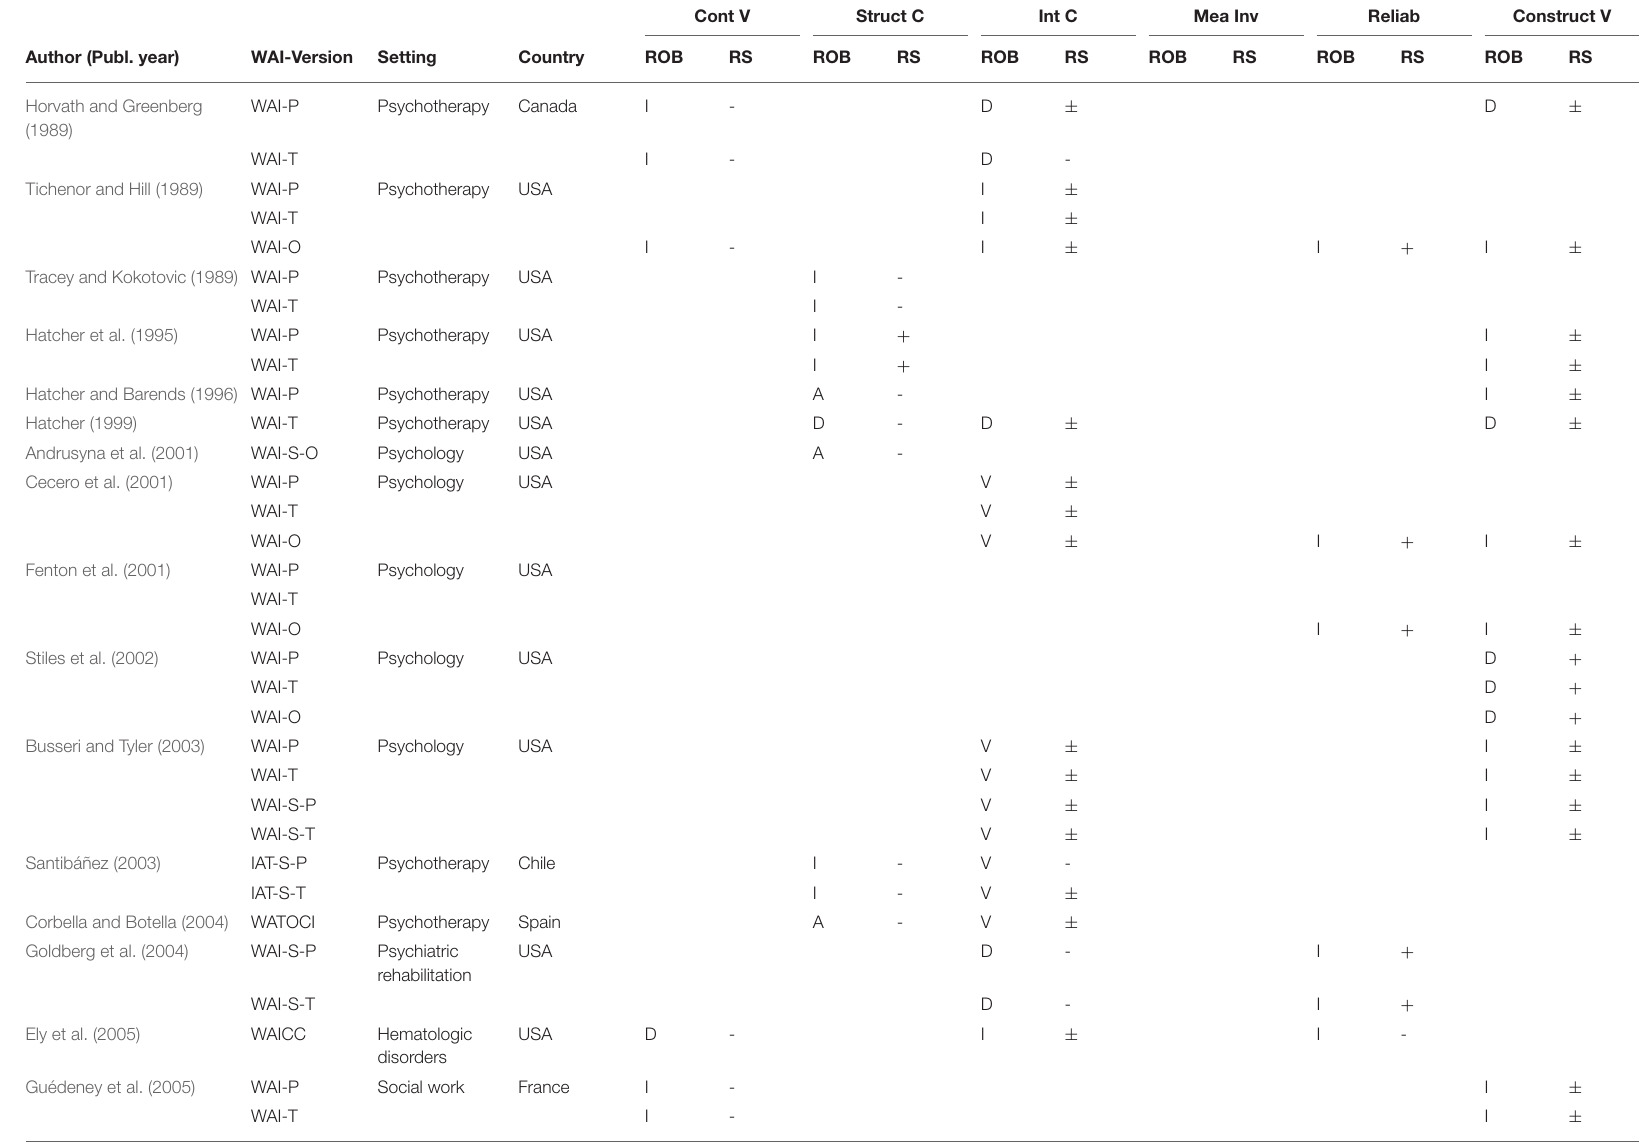
TABLE 2 | Overview of the Methodological evaluation of the WAI and all adapted versions (in total n =